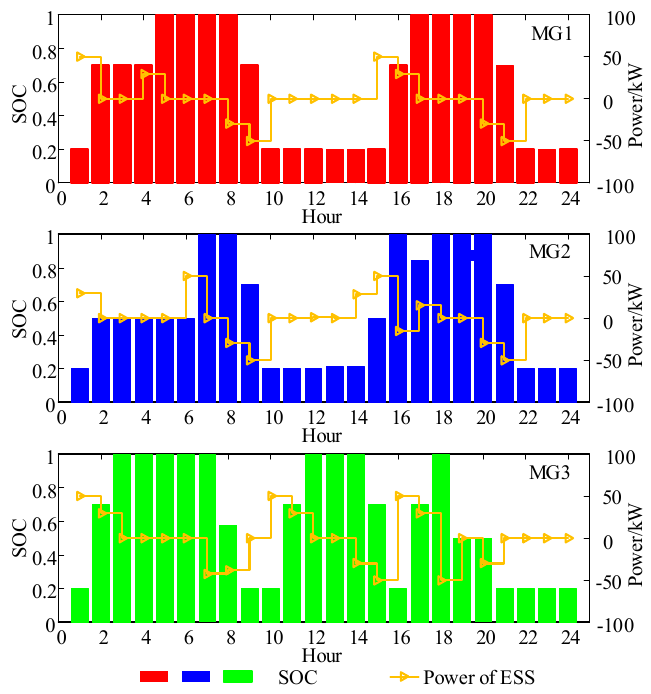
Figure 6. Optimal scheduling of energy storage systems (ESSs). SOC: state of charge.